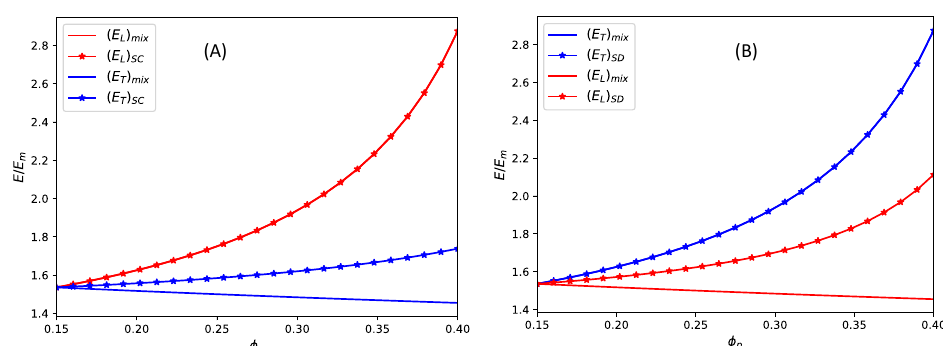
Figure A1. The elastic moduli comparison from mixture rule and elastic free energy. ( A ) For smeared columns, ( B ) for smeared